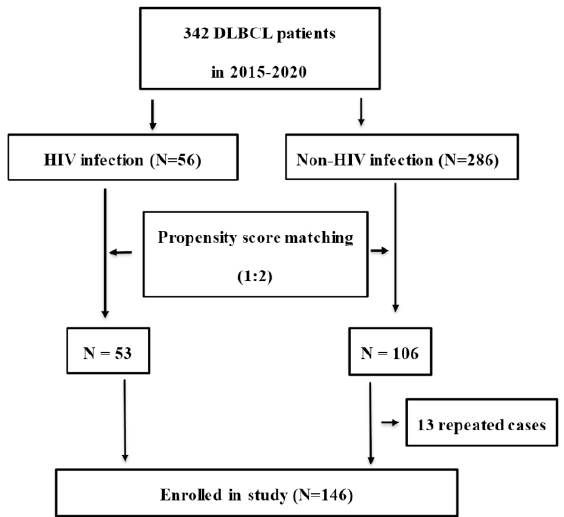
Figure 1. Study flowchart for patient selection. (DLBCL: diffuse large B-cell lymphoma).